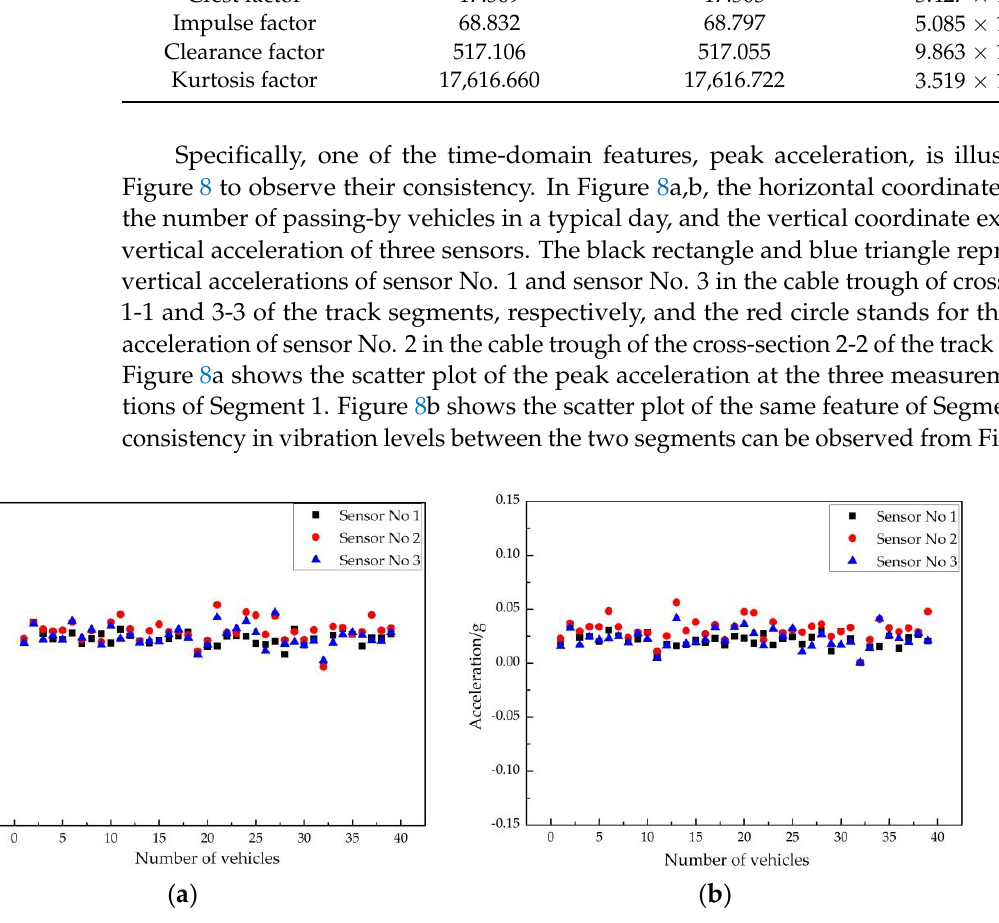
Figure 8. ( a ) Scatter plot of peak acceleration of Segment 1 in early monitoring stage. ( b ) Scatter plot of peak acceleration of Segment 2 in early monitoring stage.